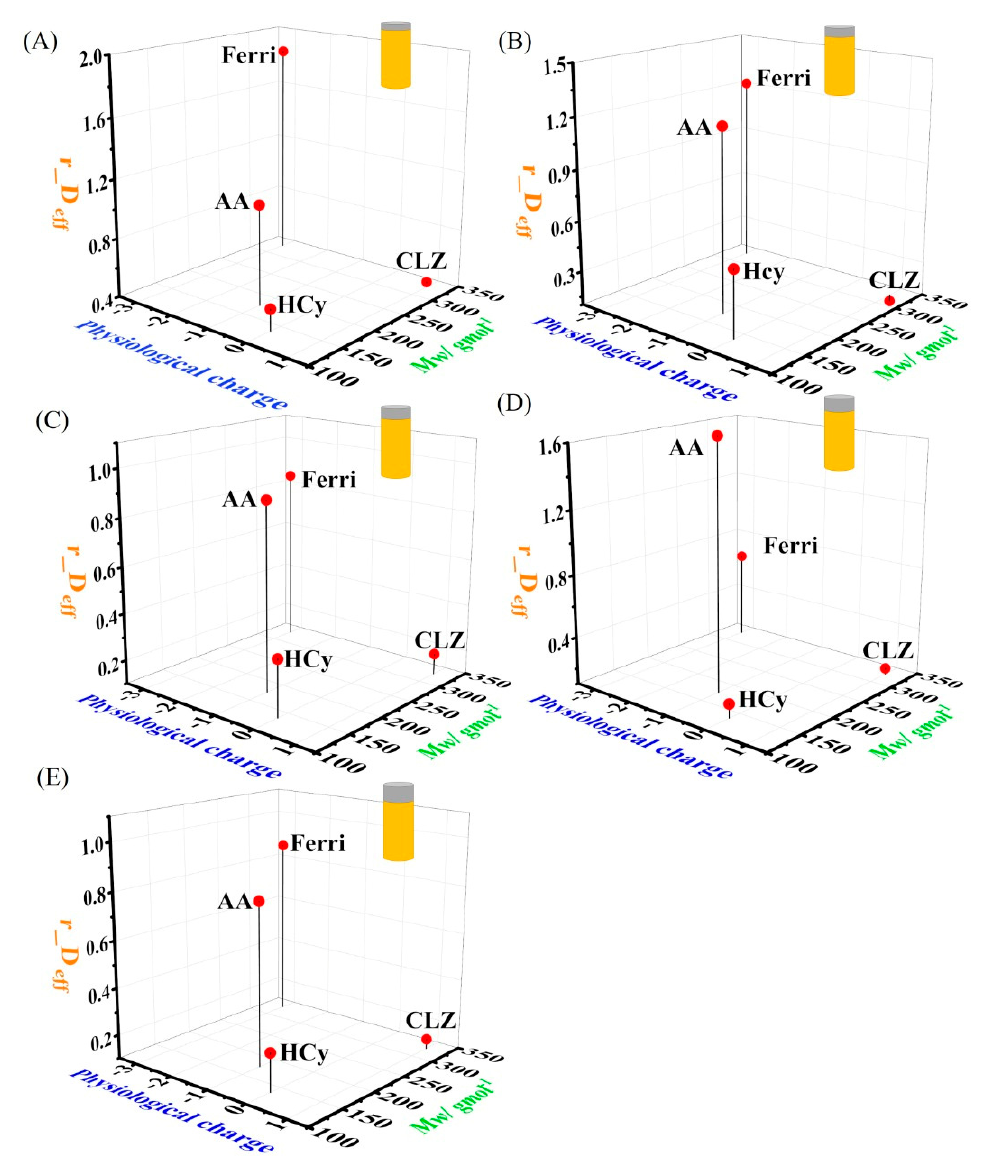
Figure 6. The differential influence of the physiological charge and the molecular weight of the redox-active molecules on the diffusion rate. The dependence of r_D eff on the M w value and the physiological charge measured for Ferri, AA, HCy, and CLZ and for a chitosan thickness of ( A ) 33.4 nm, ( B ) 40.9 nm, ( C ) 54.7 nm, ( D ) 72 nm, and ( E ) 84.1 nm.